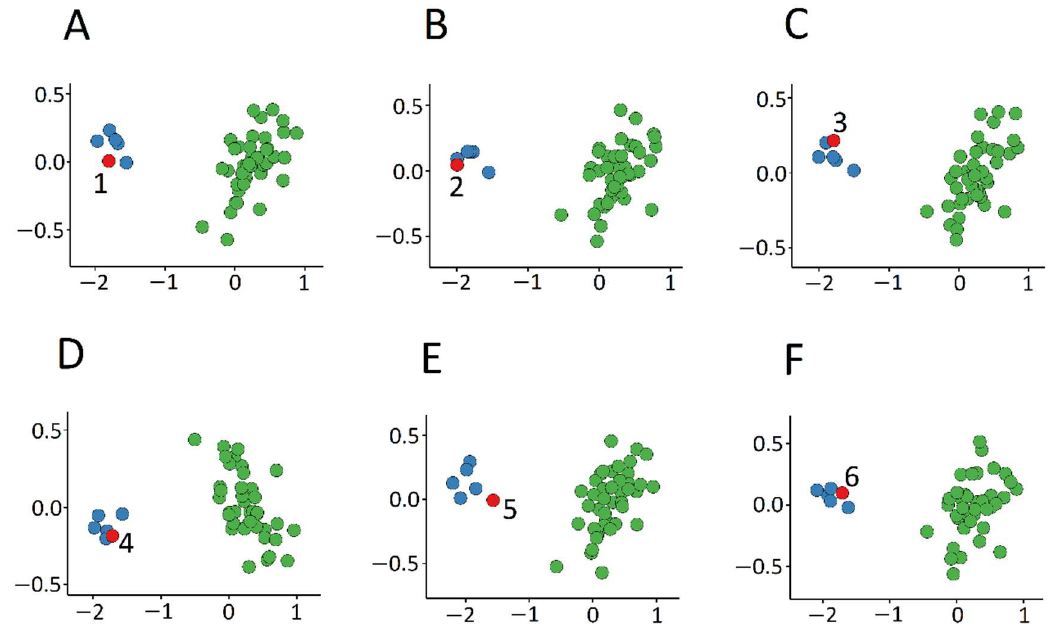
Figure 3. 6-fold cross-validation multidimensional scaling. In each of the steps ( A – F ), the red circle represents one of the Patients 1–6, respectively.